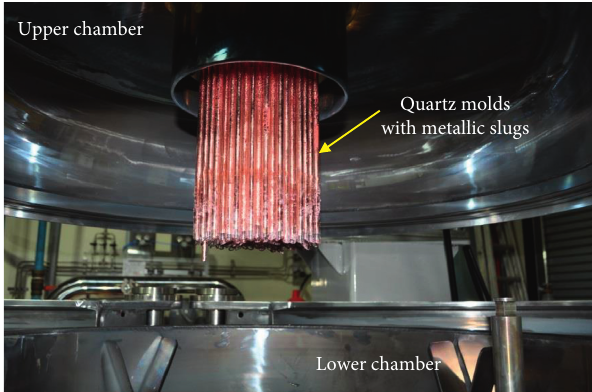
Figure 11: Quartz molds filled with metallic slugs after casting.